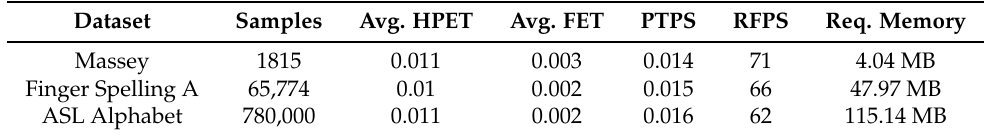
Table 9. Average hand pose estimation time (Average HPET), average feature extraction time (Average FET), prediction time per sample (PTPS), recognized frames per second (RFPS),